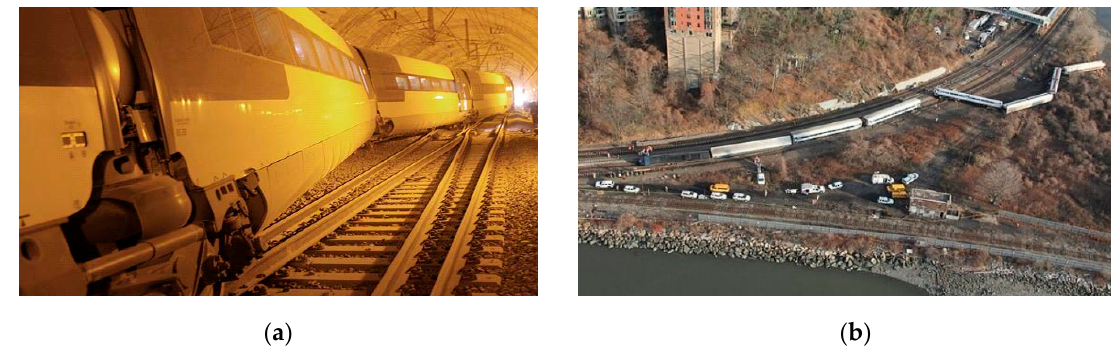
Figure 1. ( a ) The derailment accident of the high-speed train in Korea (02.2011); ( b ) the derailment accident in America (12. 2013).